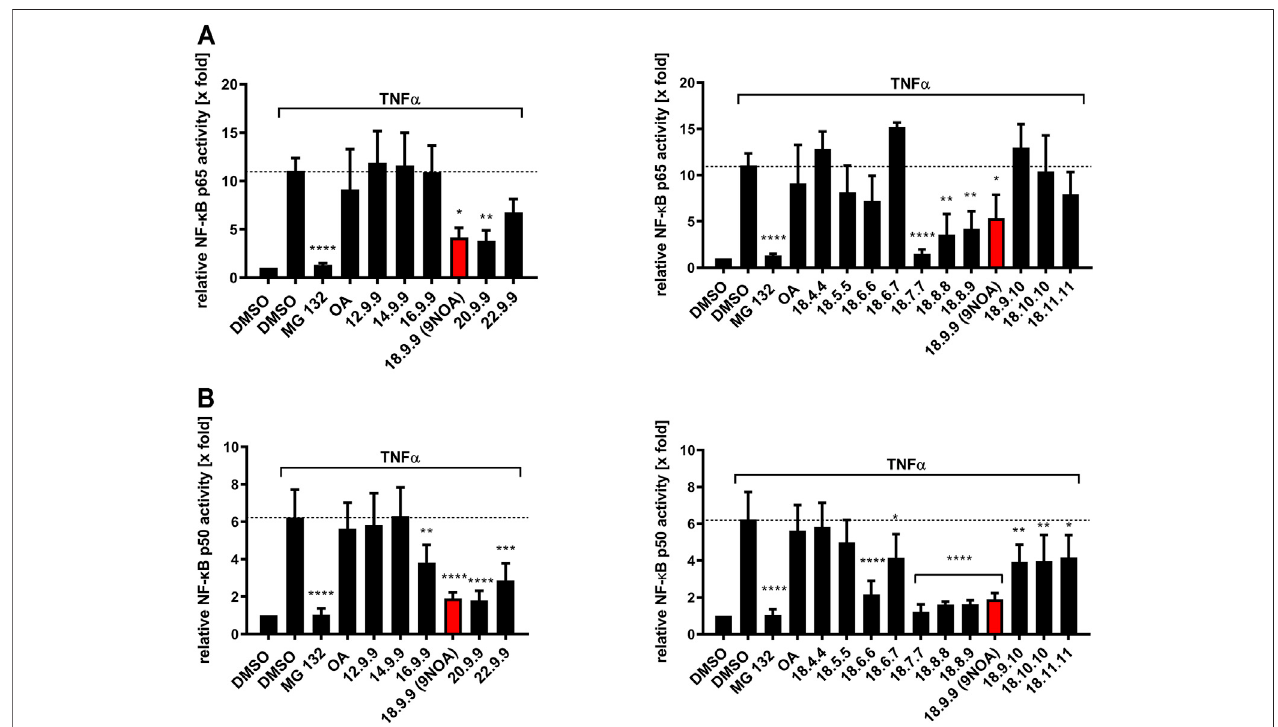
FIGURE 1 | Effects of NFA on the NF- κ B p65 and p50 signaling pathway in colorectal cancer cells. HCT-116 cells were treated with 10 µM NFA and OA for 14 h; subsequently, NF- κ B signaling was induced by stimulation with 10 ng/ml TNF- α for an additional 4 h. Incubation for 4 h with the proteasome inhibitor MG132 (1 µM) served asthe positivecontrol.NF- κ Bp65 (A) and p50 (B) inhibitionbyNFA withdifferentcarbon chainlengths and Michael acceptor positions were analyzed via ELISA. Values are normalized to protein concentration and unstimulated vehicle control. Data are represented as mean ± SD of (A) n (cid:2) 3 (DMSO, 16.9.9, 9NOA control of right panel, 18.4.4, 18.6.7, and 18.9.10), n (cid:2) 4 (all other derivatives) and (B) n (cid:2) 5. Statistical signi fi cance was calculated by one-way analysis of variance (ANOVA) with Bonferroni post-test. * p ≤ 0.03, ** p ≤ 0.0021, *** p ≤ 0.0002, **** p ≤ 0.0001 were considered signi fi cant versus TNF- α treatment. OA, oleic acid; NFA, nitro-fatty